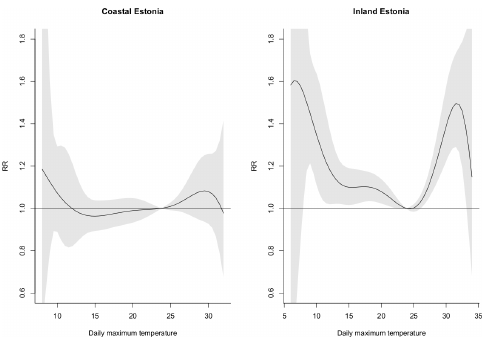
Fig 4. The estimated cumulative RR of total mortality for the daily max temperature over lags 0 – 10 for the coastal and inland